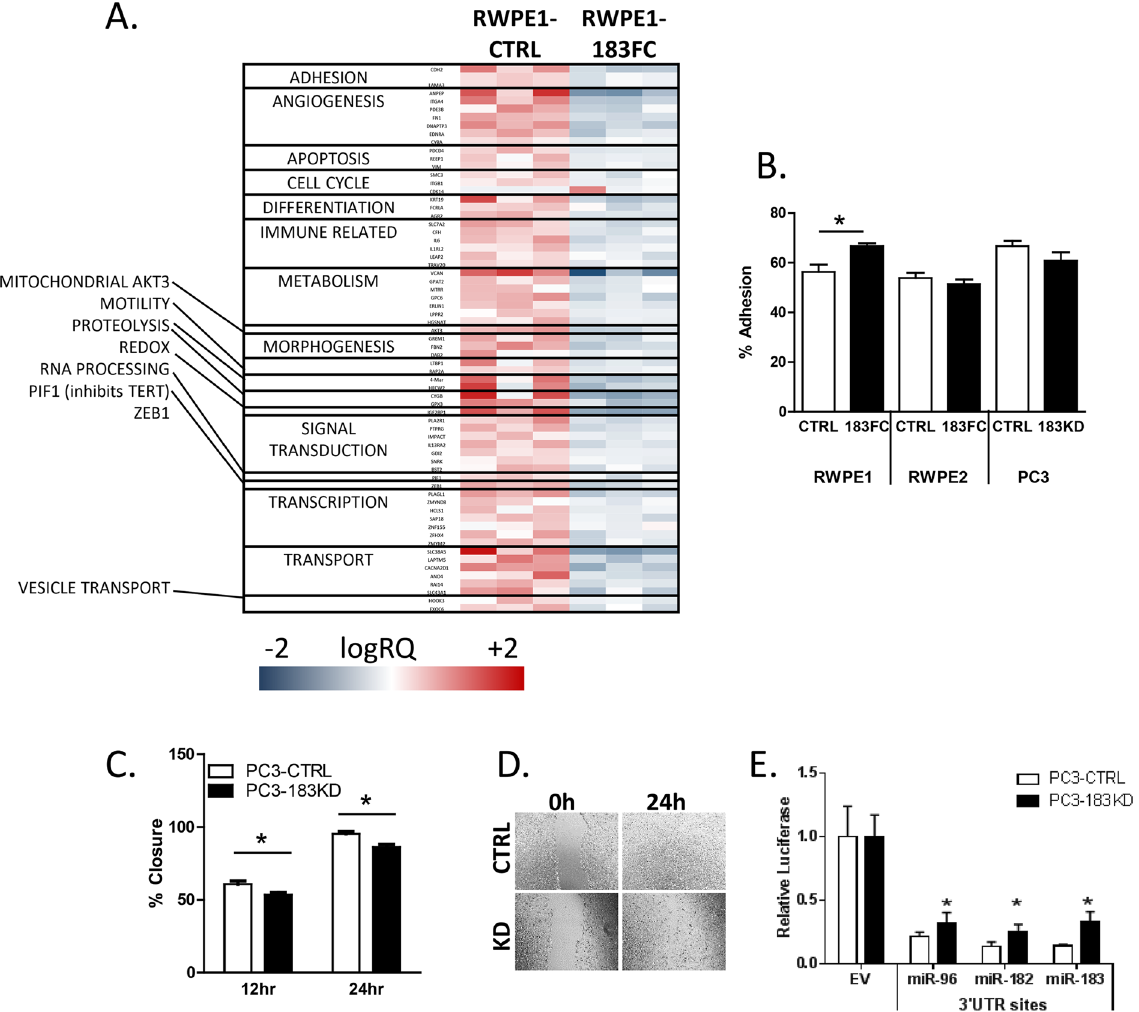
Figure 5. Overexpression of 183FC alters gene expression in RWPE1 and regulates motility and adhesion of prostate cells. ( A ) Heatmap of suppressed genes between RWPE1-CTRL and RWPE1-183FC cells. Affymetrix HT 1.0 Arrays were run on biological triplicates of lentivirus transduced RWPE1 cells sorted for GFP expression. Log 2 of the gene expression is shown and grouped by gene function. GSEA and DAVID Pathways are in shown in Supplemental Table 1. Full data were deposited into GEO (GSE99134). ( B ) Adhesion of cells at 30 minutes for RWPE1-CTRL, RWPE1-183FC, RWPE2-CTRL, RWPE2-183FC, PC3-CTRL and PC3-183KD. Bar graph shows mean and SEM for n = 4. ( C ) Migration of PC3-CTRL and PC3-183KD by scratch assay shown as bar graph for mean and SEM for n = 4, and, ( D ) Representative images of the scratch closure. ( E ) Respective levels of miR-specific luc-3 ′ UTR plasmids compared to empty vector (EV) after 24 hours in PC3-CTRL and PC3-183KD cells. Mean and SEM are shown, (n = 2). Student’s paired 2-sided t-test, * p <